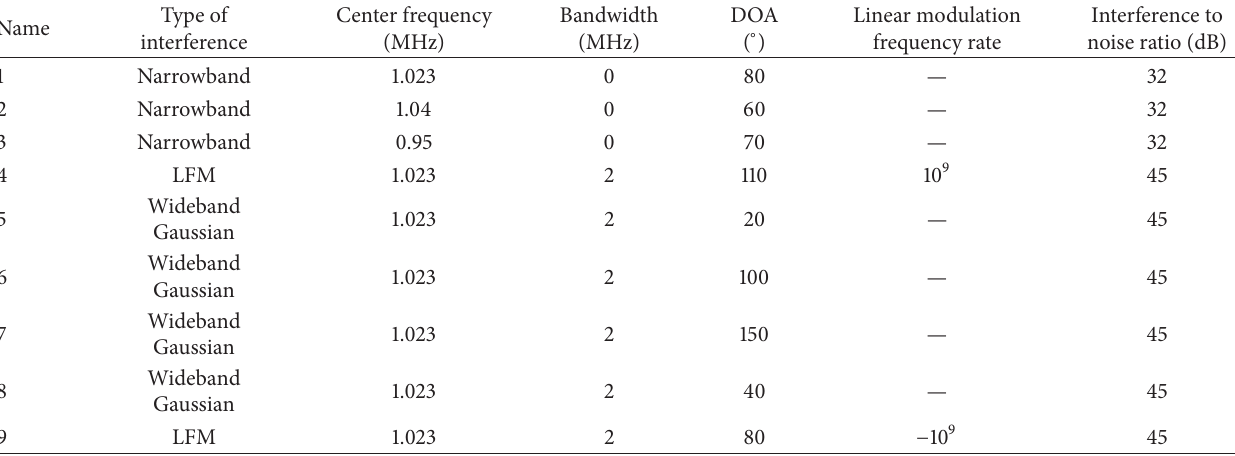
Table 1: Interference signals characteristics.